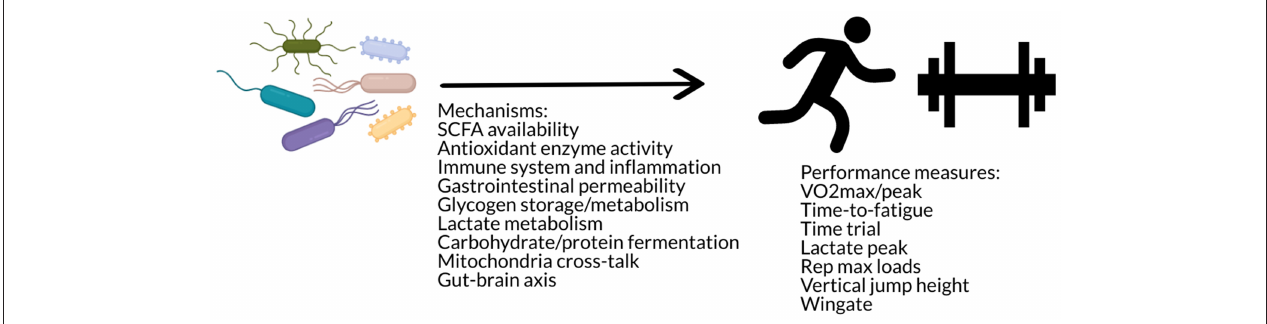
FIGURE 4 | The gut microbiome may influence performance via mechanisms such as antioxidant enzyme activity, immune modulation, gastrointestinal permeability, substrate utilization and storage, mitochondria cross-talk, and/or the gut-brain